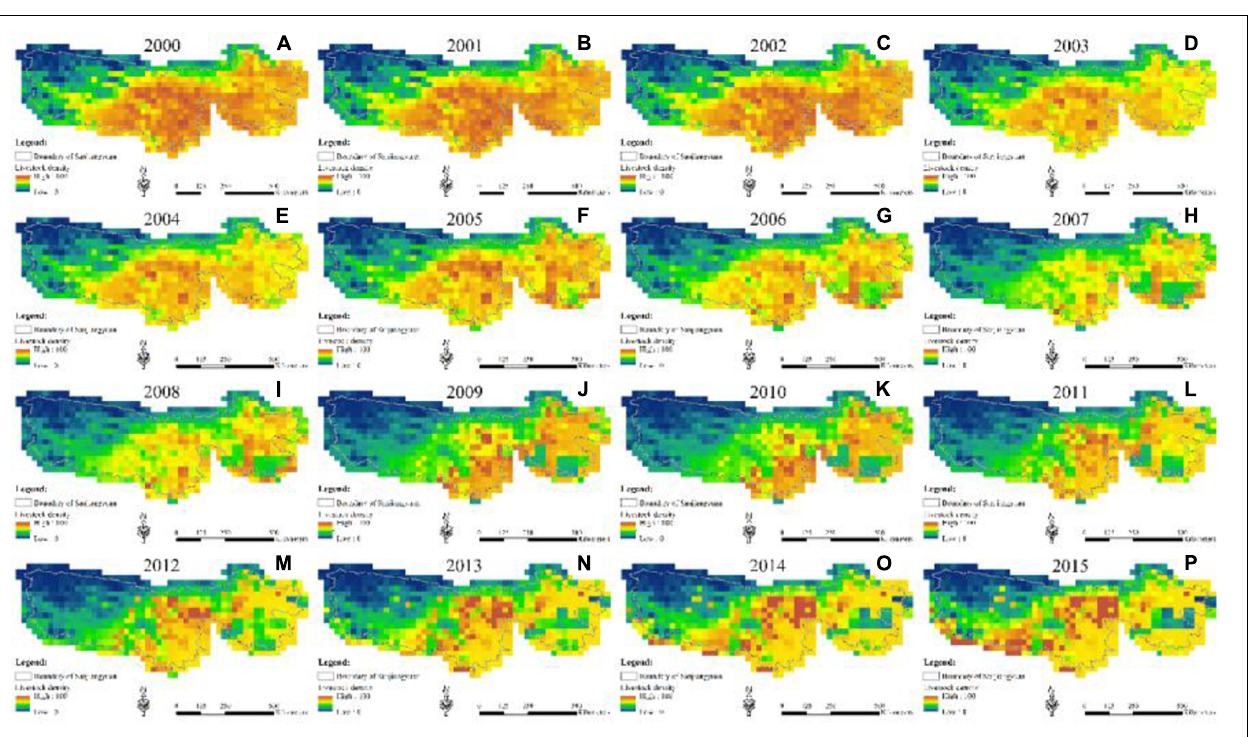
FIGURE 4 | Annual changes of the average number of livestock (i.e., yaks, Tibetan sheep, and horses) from 2000 to 2015.